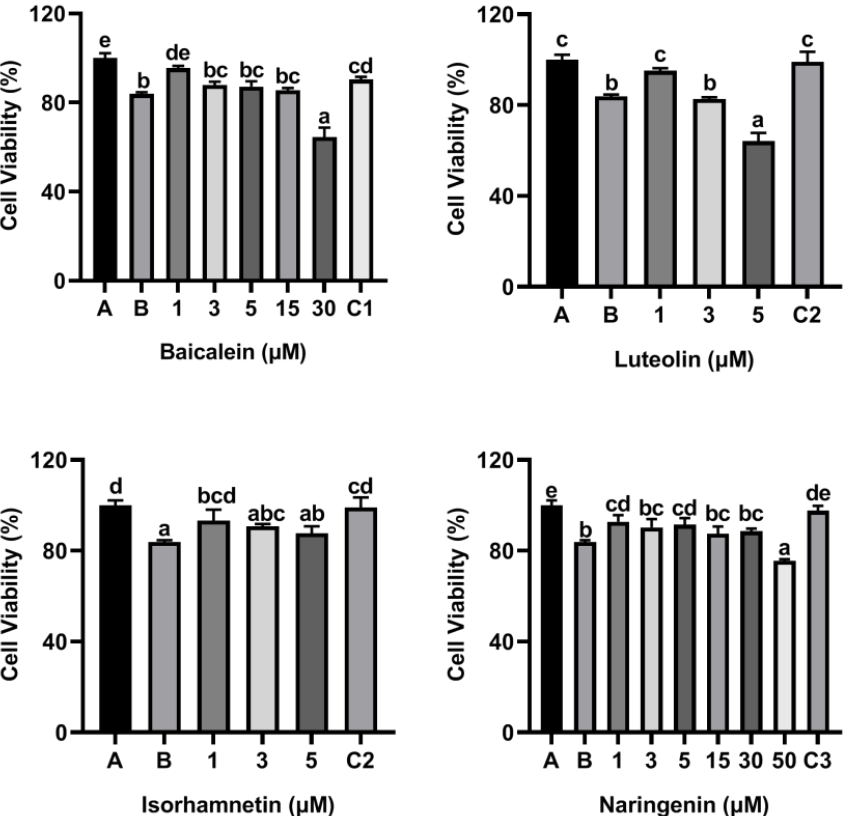
Figure 2. Effects of four flavonoids on the viability of KU812 cells induced by ω -5 gliadin-derived peptide P4. A (blank group): only KU812 cells; B (control group): 500 μg/mL ω -5 gliadin-derived peptide P4+KU812 cells; C1 (positive control group) : 30 μM ketotifen fumarate + KU812 cells; C2 (positive control group) : 5 μM ketotifen fumarate + KU812 cells; C3 (positive control group) : 50 μM ketotifen fumarate + KU812 cells. Note: different letters indicate significant differences between groups ( p < 0.05).